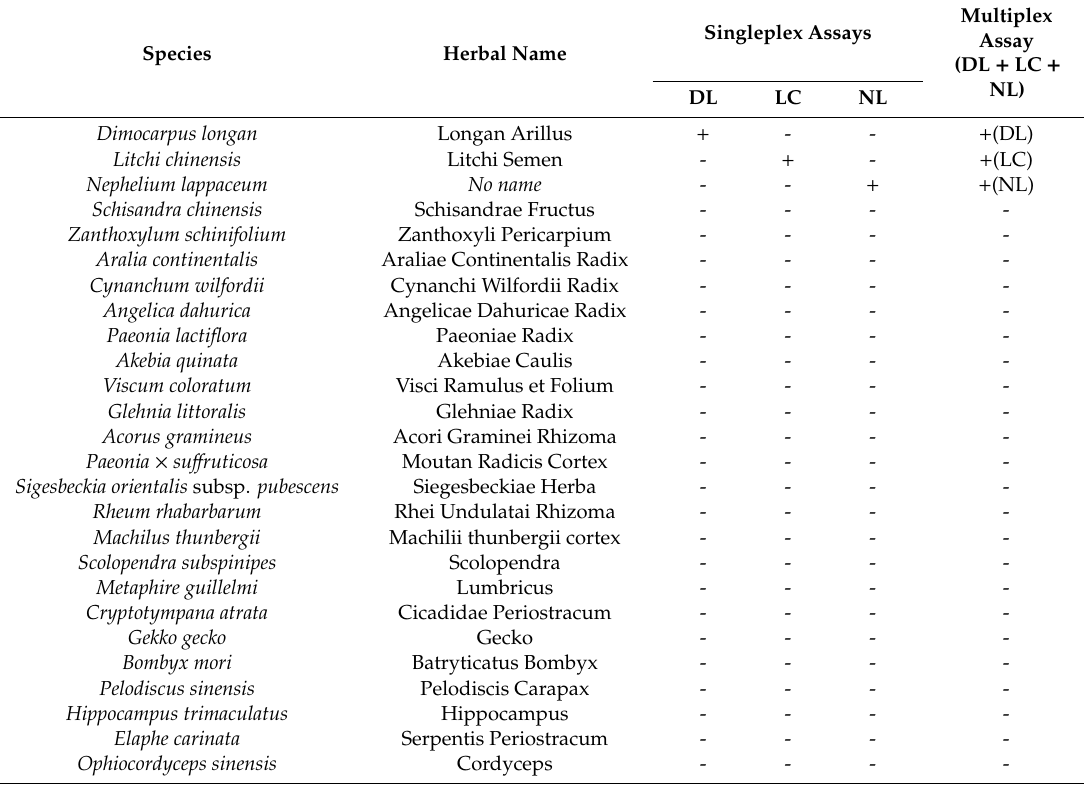
Figure 4. Discriminability in mixed samples of two or three species ( D. longan , L. chinensis , and N. lappaceum ) using the multiplex PCR assay. M: 100 bp DNA size marker (100–1000 bp). Arrowheads indicate the amplified fragment sizes. Table 3. Specificity of singleplex and multiplex PCR assays based on cross-reactivity with plant, animal, and fungal taxa used as herbal